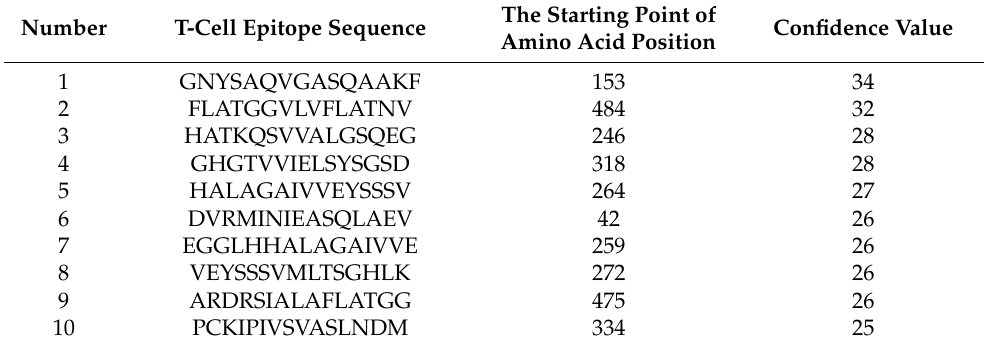
Table 2. Common T-cell antigenic epitope sequence of JEV isolate E protein.